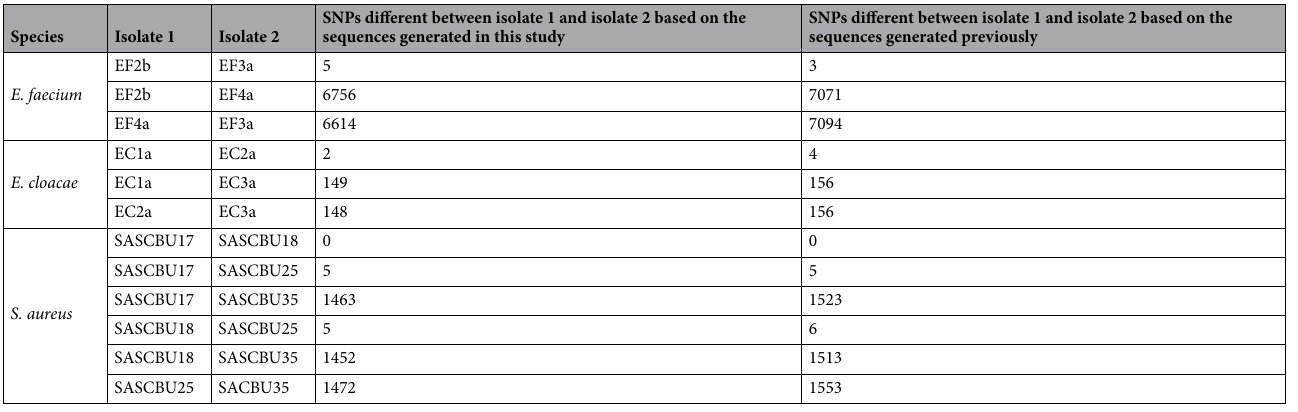
Table 2. Genetic relatedness between isolates suspected to be involved in outbreaks. Table shows the pairwise SNP differences based on sequence data produced in this study and the sequence data produced previously 7,8 for isolates suspected to be part of an